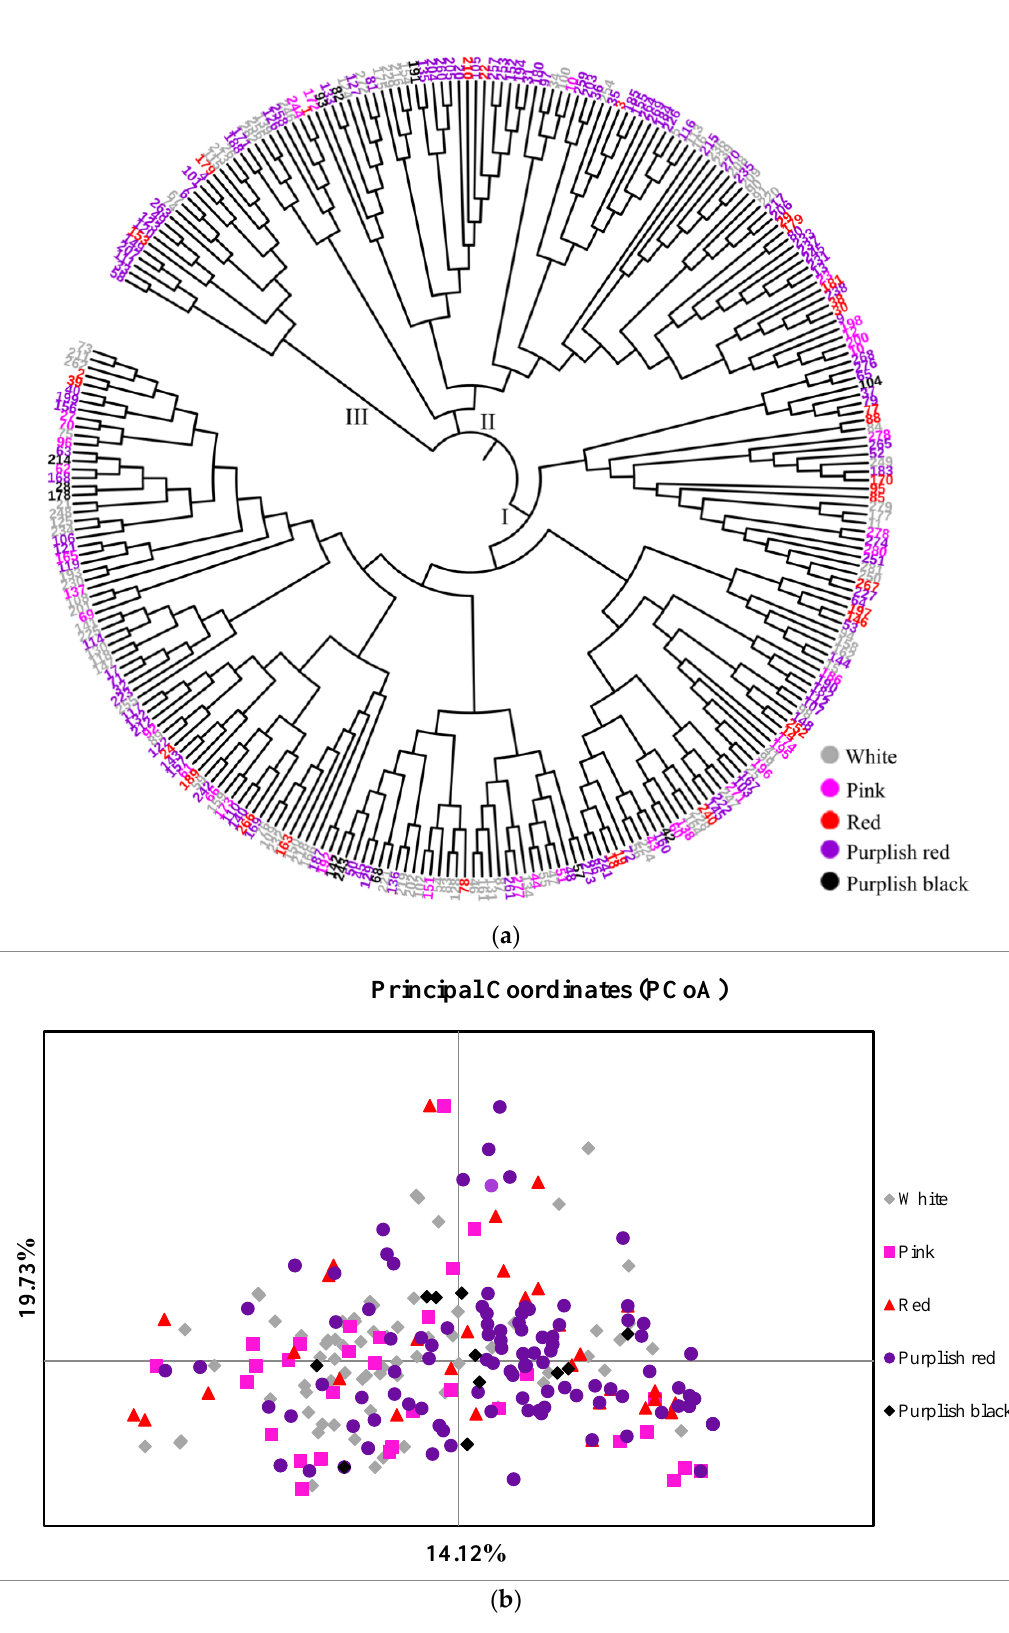
Figure 4. Relationships among 282 accessions: ( a ) Neighbor-Joining (NJ) phylogenetic tree based on the data of 34 EST-SSR markers, ( b ) Principal coordinates analysis (PCoA) based on Nei’s unbiased genetic distance.